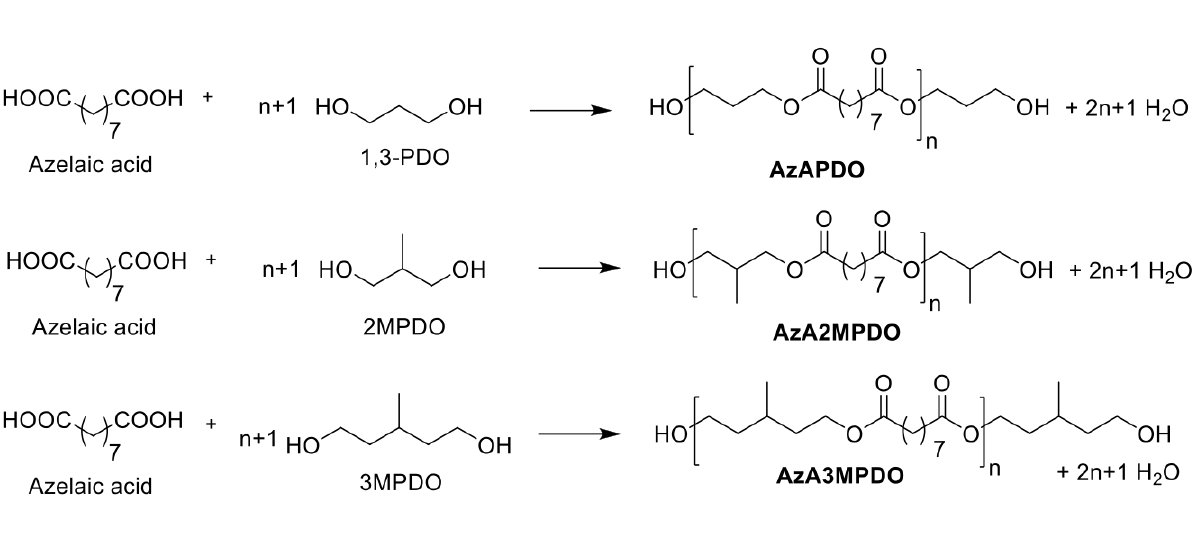
Table 1. Polyester polyol formulations.